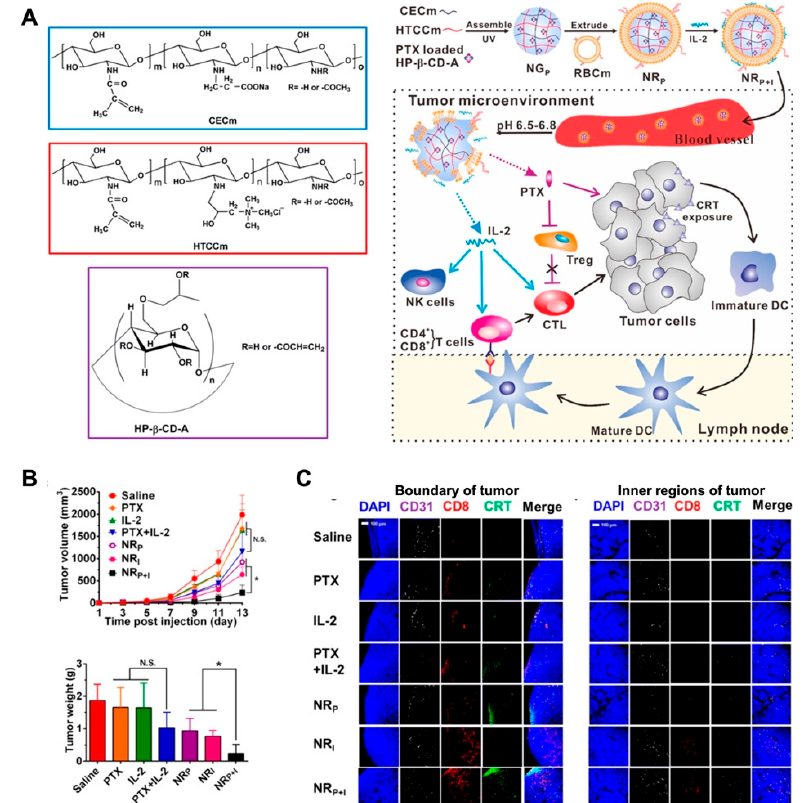
Figure 11. ( A ) The schematic illustration of the procedure of multifunctional nanogel NR P+I , and the mechanism for combinatorial chemo-immunotherapy; ( B ) the tumor volume and tumor weight of each group with corresponding treatment, which indicated the improved synergistic effect of chemo-immunotherapy; ( C ) immunofluorescence staining for of CD31, CRT and CD8+ cells in tumor sections of different treatments, which implied the remodulation of tumor microenvironment for combinatorial immunotherapy. Adapted with permission from (Nano Letters 2017, 17, (10), 6366–6375). Copyright (2017) American Chemical Society.